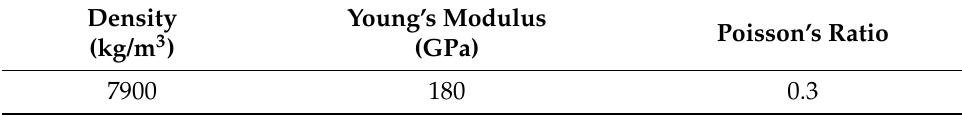
Table 1. Mechanical properties of steel.